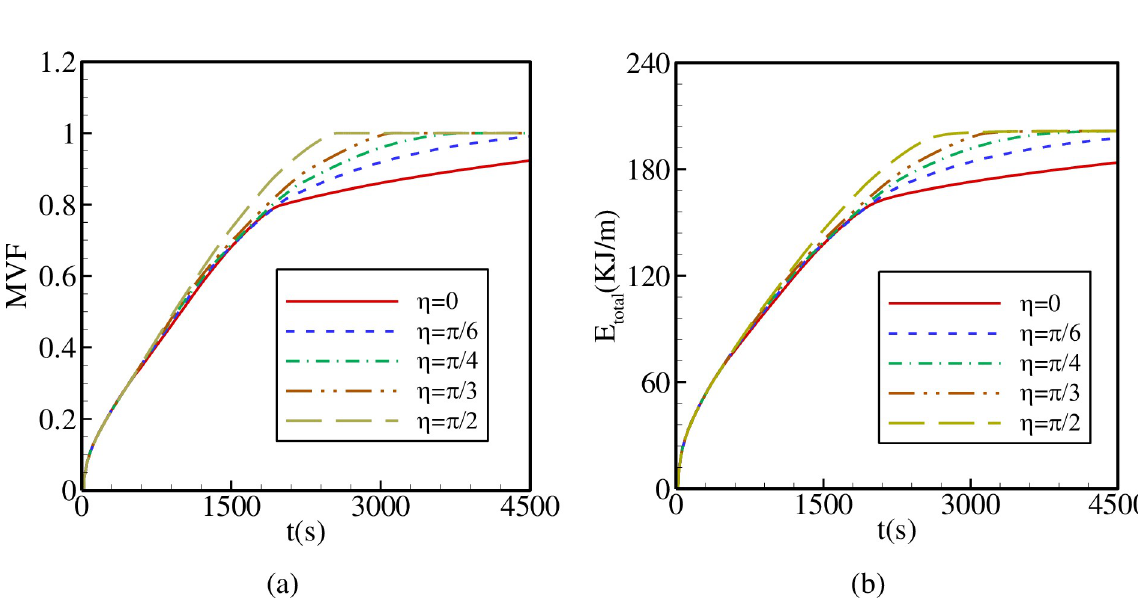
Fig 13. The effects of η on (a): the melt volume fraction (MVF); (b): the total energy stored (E total ) when r